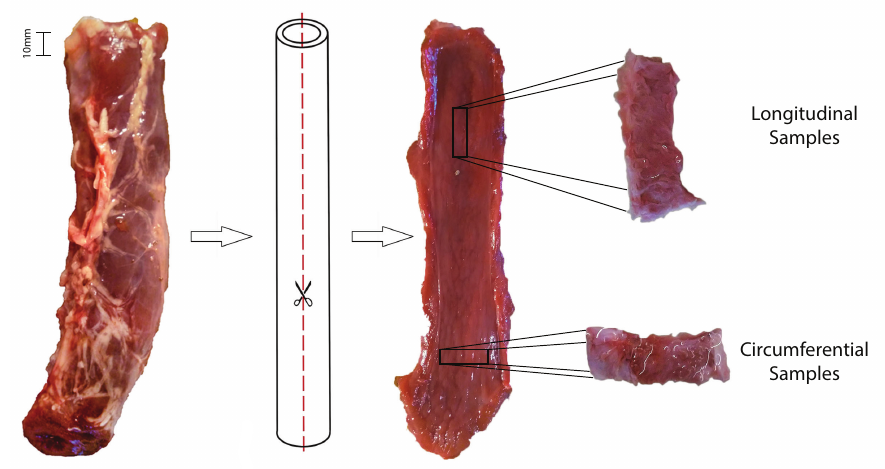
Figure 3. Longitudinal and circumferential urethral samples.